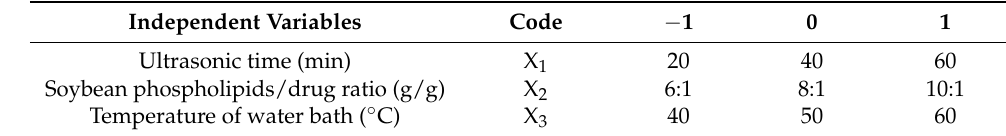
Table 2. Levels of independent variables for the Ori liposomes